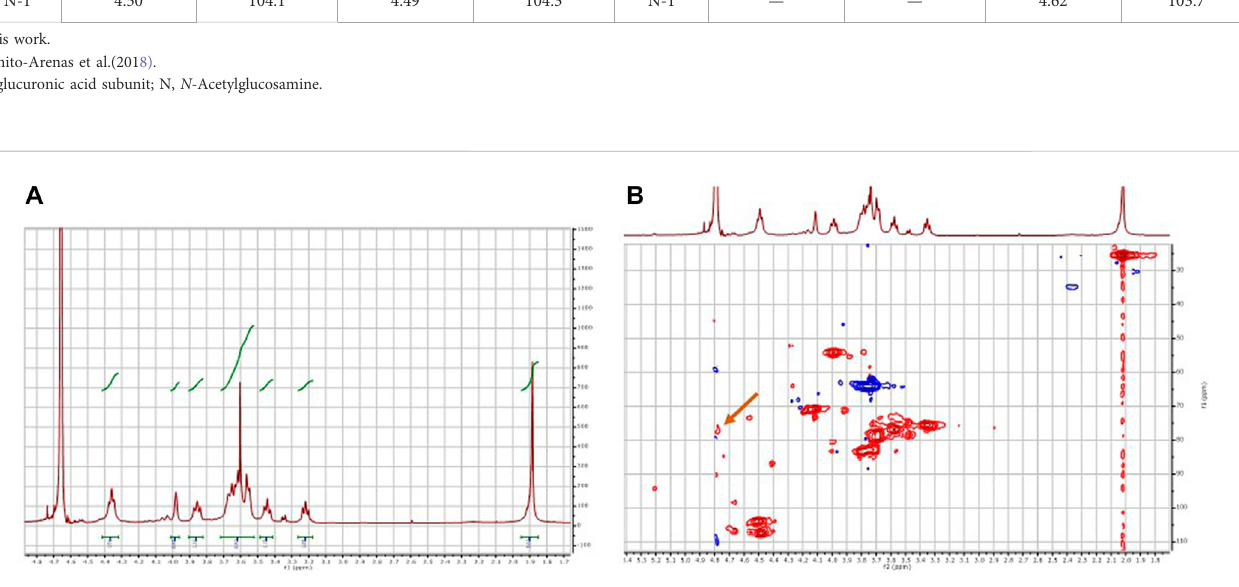
Frontiers in Bioengineering and